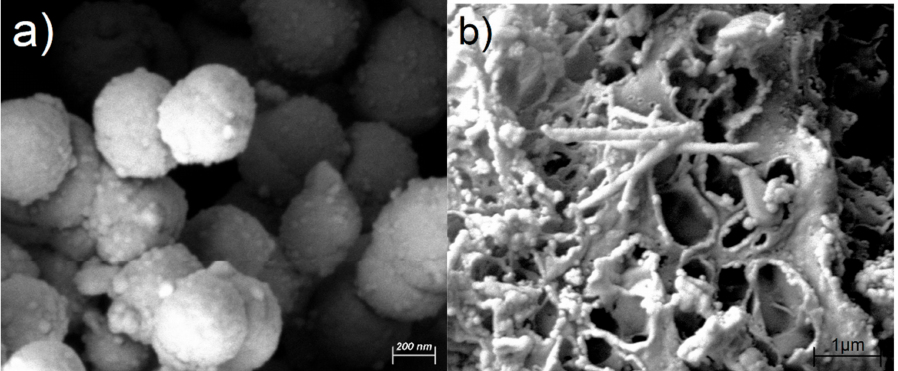
Figure 6. SEM images of ( a ) Al nono-particles and ( b ) Al-Si nano-rods produced from metallized paper annealed at 1500 ◦ C for 5